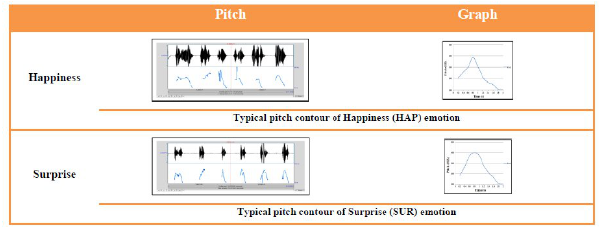
Fig. 4. Asian pitch contours for Happiness and Surprise.